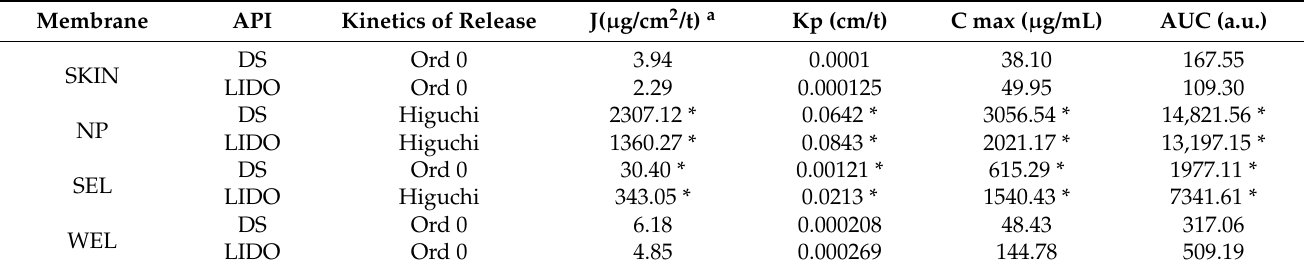
Table 4. Average values of Kp, J, Cmax, and area under the curve (AUC) of penetration of the DS 3% and LIDO 2% solution for all